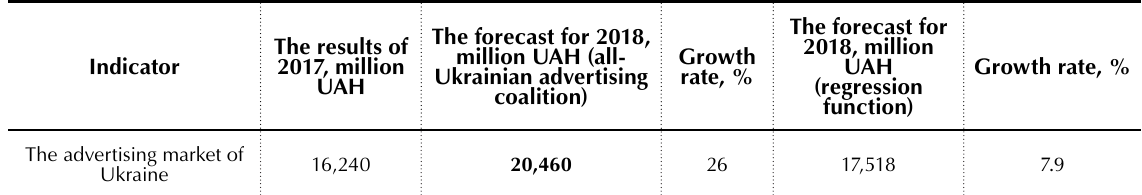
Table 4. The comparative characteristic of forecasts of volume of the advertising market of Ukraine for